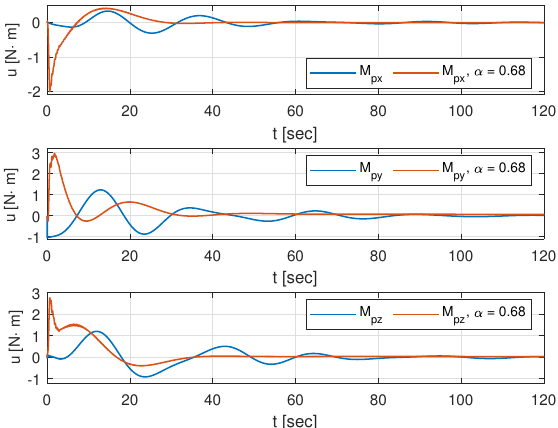
Figure 18. Actuator with a larger torque.